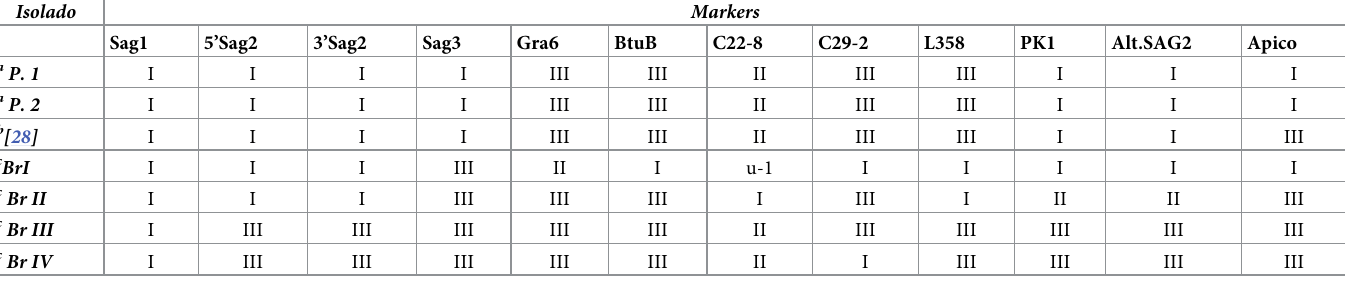
Table 2. Genotypic characterization of T. gondii isolates obtained from two patients during the Santa Maria toxoplasmosis outbreak compared to three other iso- lates [9,28].